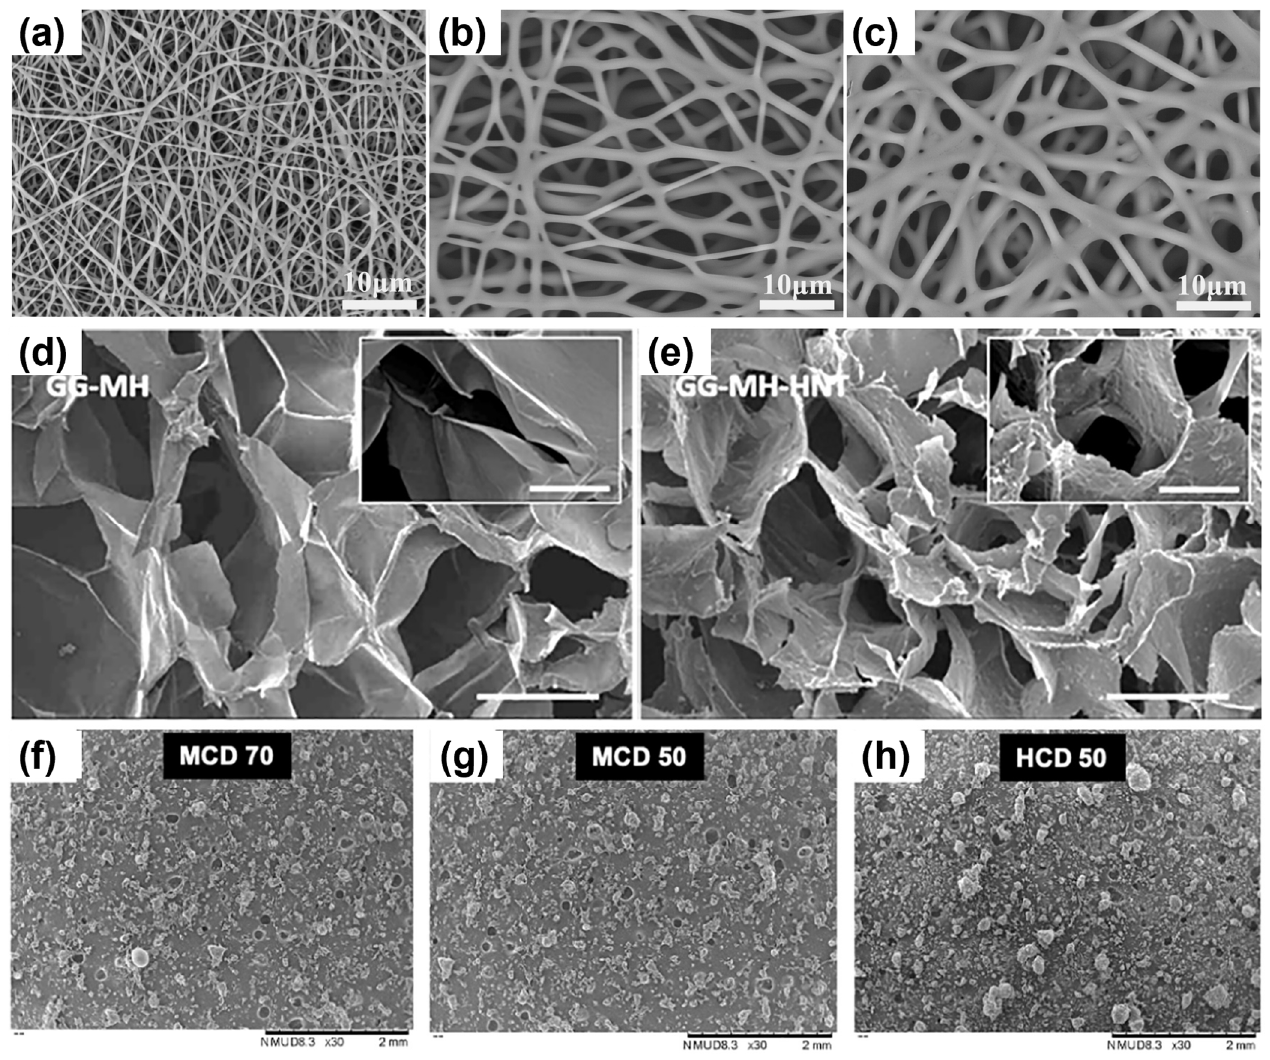
Figure 5. Honey-containing scaffolds. Scanning electron microscopy images of electrospun fibres containing ( a ) 0%, ( b ) 30%, and ( c ) 70% manuka honey [212]; ( d ) gellan gum hydrogels with 2% manuka honey and ( e ) reinforced with clay halloysite nanotubes [240]; and freeze-dried powders using methylated- β -cyclodextrin and ( f ) 70% or ( g ) 50% SurgihoneyRO™ and ( h ) (2-hydroxypropyl)- β -cyclodextrin with 50% SurgihoneyRO™ [254]. Reproduced with permission from Elsevier.